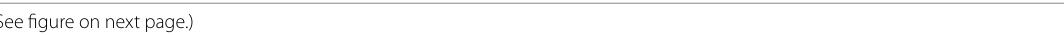
figure on next Fig. 3 Sandalore mediates an increase of intracellular calcium via a cAMP-dependent pathway. AM were stimulated three times for 1 min each with 300 µM Sandalore ( A , dark grey). Intermediary washing steps removed the odorant or inhibitor. B Repetitive application of 300 µM Sandalore with co-application of 300 µM Oxyphenylon (second application, light grey). EGTA 10 mM ( C ) and MDL-12,330A 10 μM ( D ) were pre-incubated for three (EGTA) or five minutes (MDL 12,330A) before adding Sandalore in the second application (light grey). Data are shown as mean donors). Data were analyzed with the Student’s paired t -test referring to the third Ca 2 + amplitude induced by Sandalore. *p